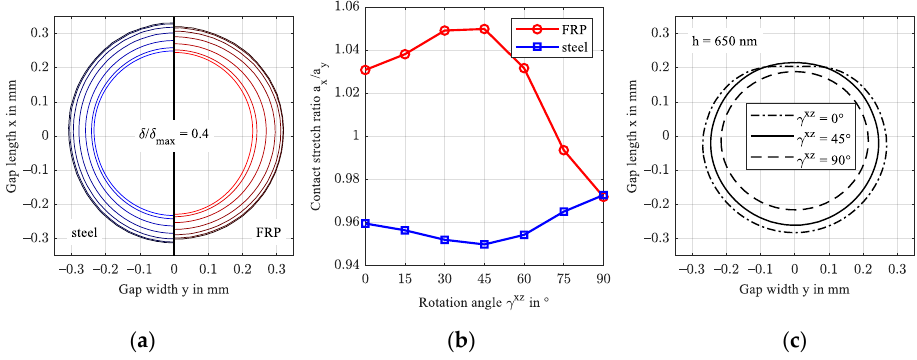
Figure A3. Normalized contact deformation of the steel and FRP surface for increasing rotation angle in the xy-plane ( a ) and contact stretch ratio ( b ) and isocontour of a film thickness level of 650 nm ( c ).